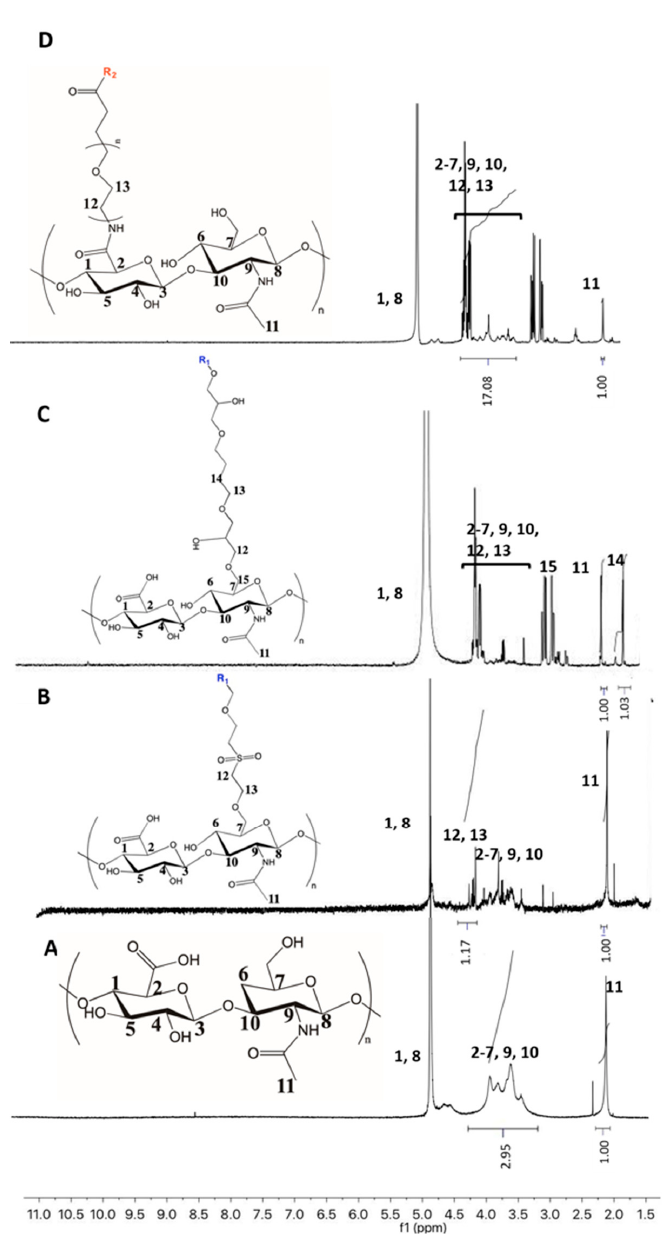
Figure 3. Nuclear magnetic resonance ( 1 H-NMR) spectra of hyaluronic acid (2.1 MDA) in D 2 O ( A ) and HA nanogels prepared by its crosslinking in microemulsion with ( B ) DVS, ( C ) PEGBNH 2 , and ( D ) BDDE in a molar ratio HA: crosslinker of